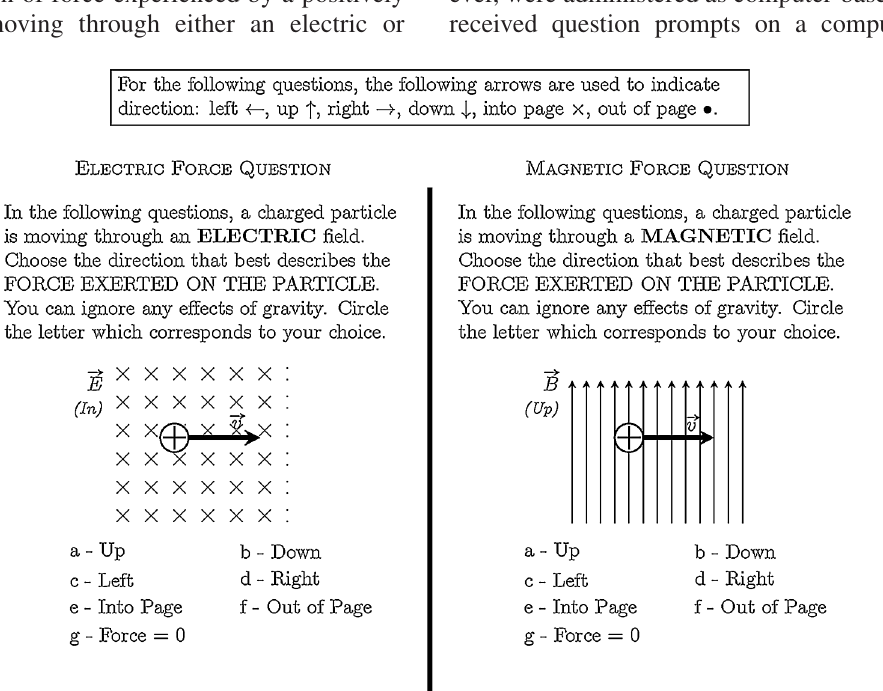
FIG. 1. Example showing question text and illustrations received by students who were questioned with the field line representation. Each student answered eight questions in which the direction (up, right, into, and out of) and type (electric and magnetic) of field were